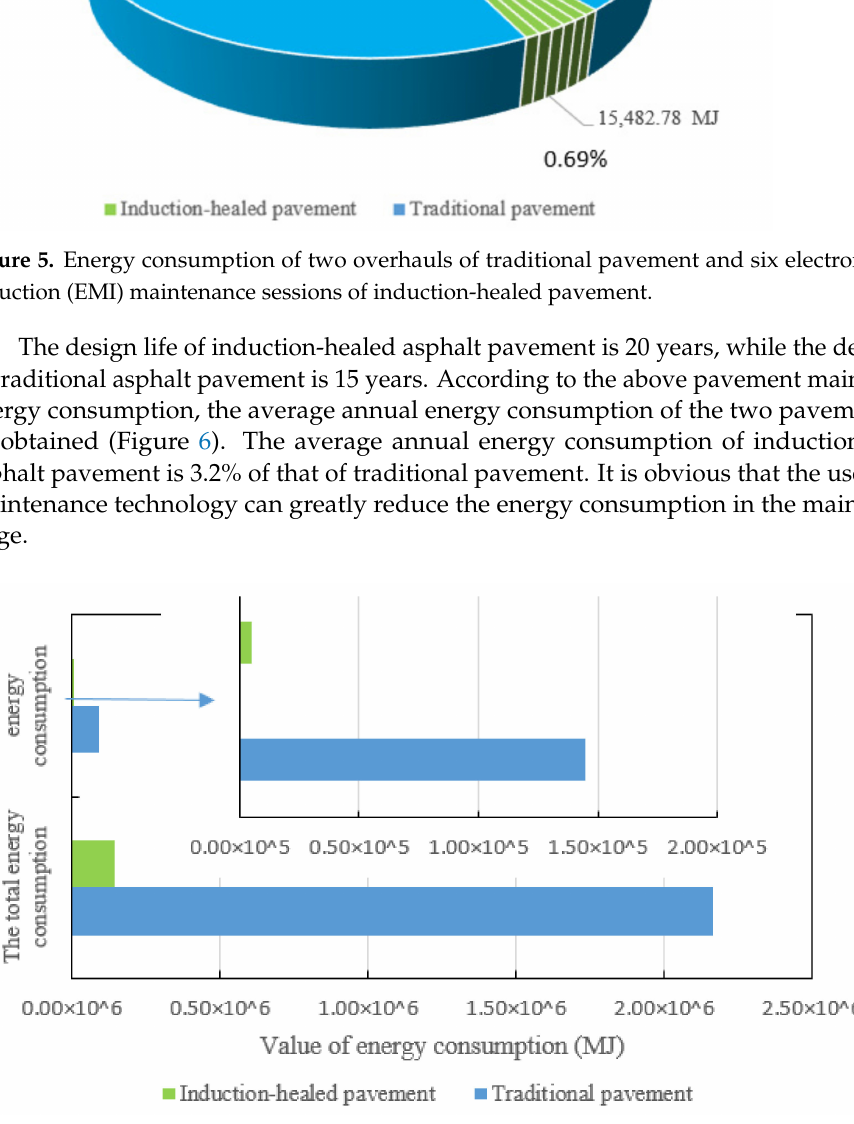
Figure 6. Energy consumption comparison of two asphalt pavements’ maintenance in their design